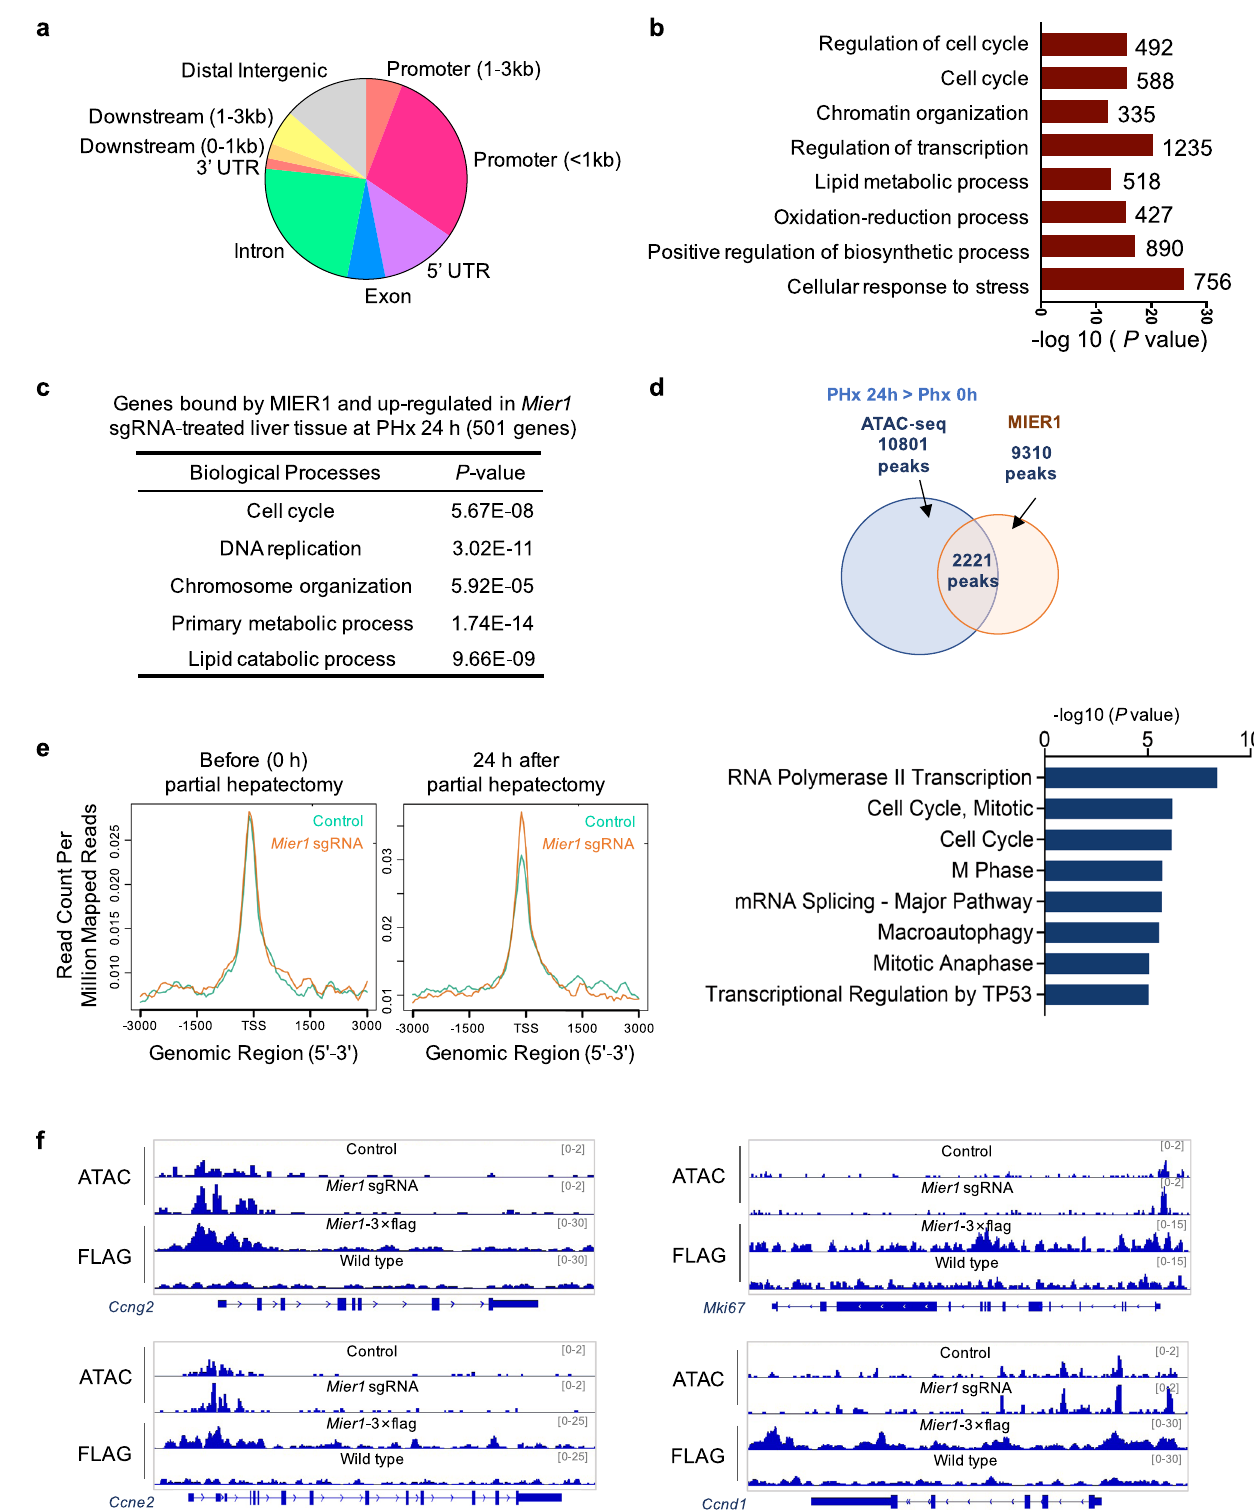
Fig. 2 | MIER1 targets and regulates cell cycle gene expression through chro- matin remodeling. a Genomic distribution of MIER1 binding sites. b Gene enrichment analysis of genes bound by liver MIER1. Numbers of genes in each GO termareshown. c GeneenrichmentanalysisofgenesbothboundbyMIER1andup- regulated in Mier1 -depleted liver tissue. d Overlapped peaks of liver MIER1 with increasedATAC-seqpeaksat24hpost-surgeryascomparedtoonesbeforesurgery